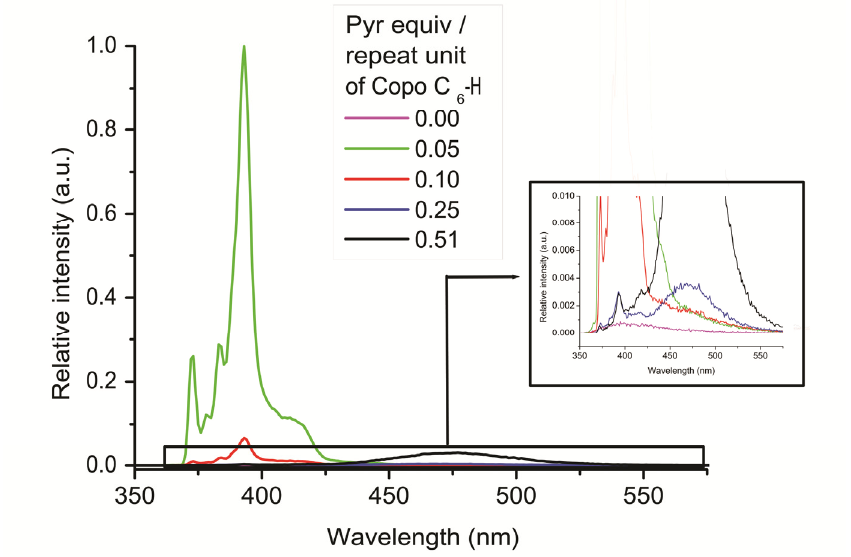
Figure 6. Photoluminescence spectra (emission mode, excitation at 338 nm) of “host-guest” materials Copo C -H/Pyr in the solid 6